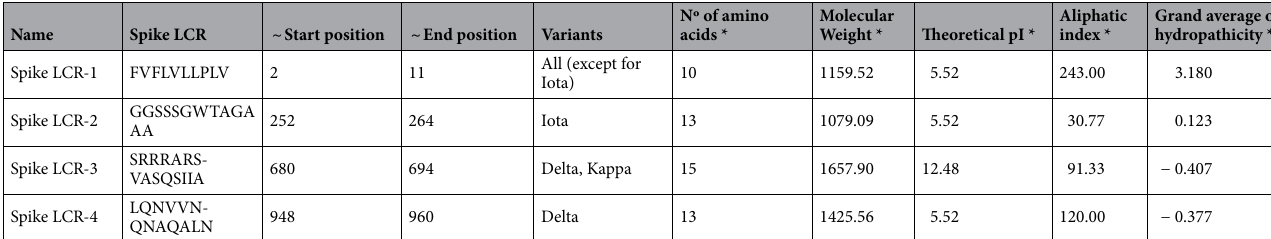
Table 1. Spike proteins LCRs reported in this work for the Delta, Iota and Kappa variants. The position of each LCR in the spike sequence is indicated. The first letter of the name corresponds to the protein in which the LCR is located, and the number corresponds to its position in each of the SARS-CoV-2 proteins. (*) This information was derived from https:// www. expasy. org/ resou rces/ protp aram.